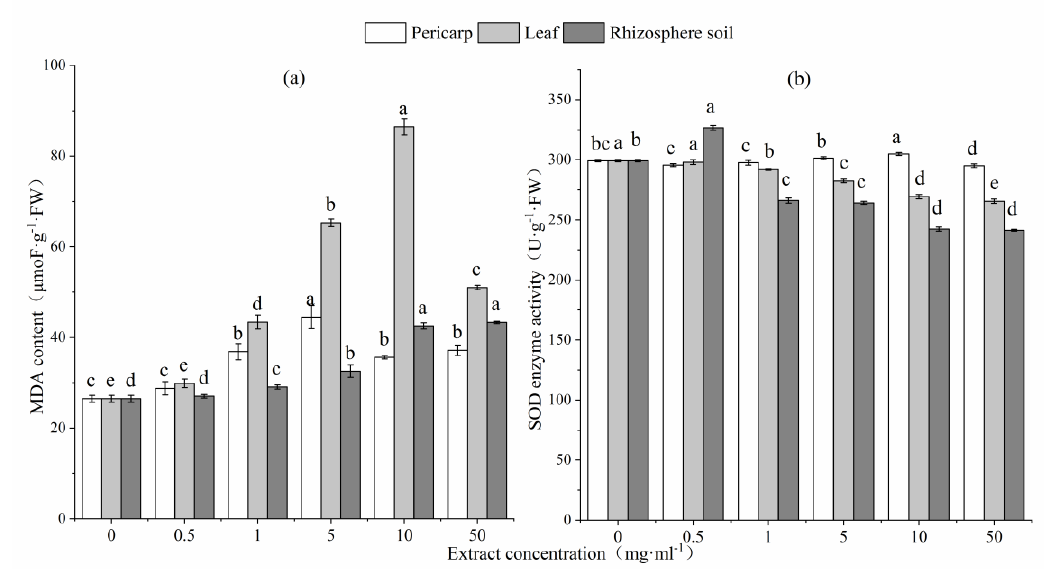
Figure 4. MDA content of ( a ) and SOD enzyme activity in ( b ) L. formosana seedlings following treatment with different concentrations of C. migao pericarp, leaf, and rhizosphere soil aqueous extracts. Lowercase letters represent significant differences in each treatment group ( p < 0.05).